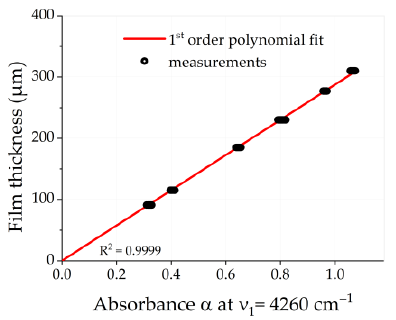
Figure 3. Known film thicknesses 𝛿 of the calibration set over respective absorbance values 𝛼 at 𝜈 1 = 4260 cm −1 (black dots) and corresponding first-order polynomial fit of the data points (red line).